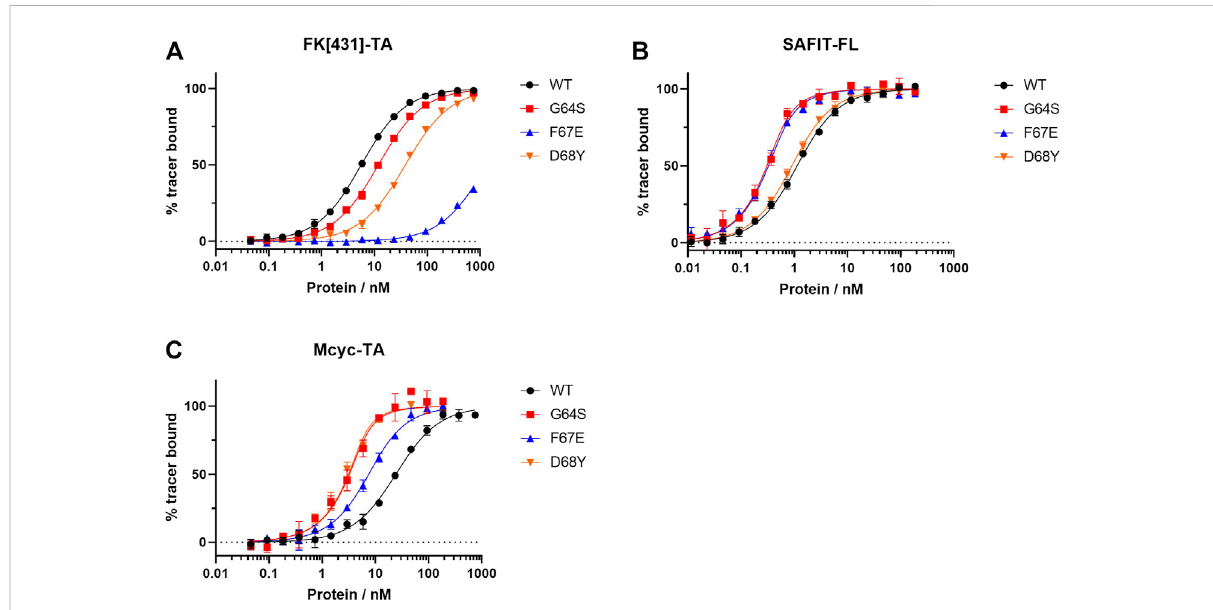
FIGURE 5 FluorescencepolarizationassayforthebestthreeFKBP51variantsusing (A) thecanonical FK1tracerFK[431]-TA (in/in) , (B) SAFit-FL (out/in) and (C) Mcyc-TA (out/out)